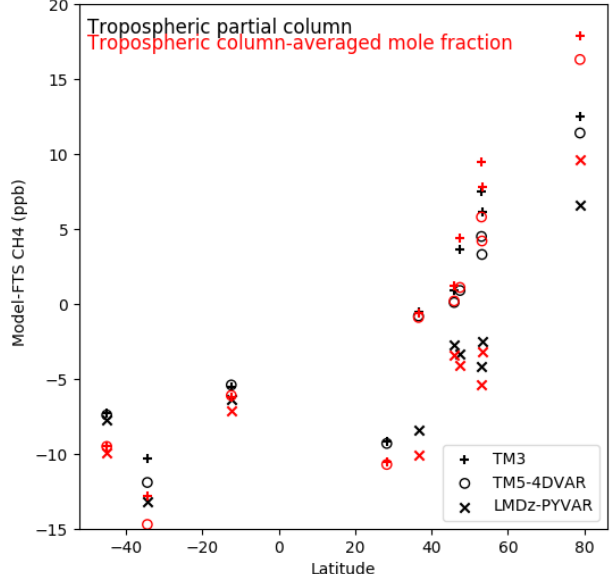
Figure A1. Latitudinal dependences of yearly averaged model bi- ases in the tropospheric partial column (black) and the tropospheric column-averaged mole fraction (red). The three models are rep- resented by plus (TM3), circle (TM5-4DVAR) and multiplication (LMDz-PYVAR)